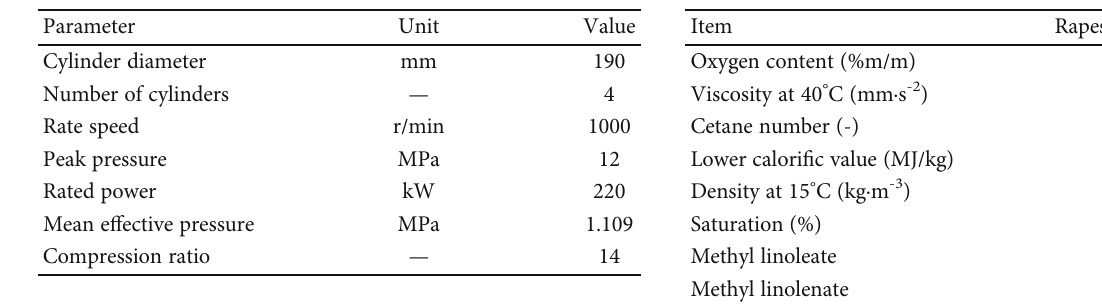
Figure 1: Simulation model of the entire diesel engine. Table 2: Main parameters of diesel engine. Table 3: Physical properties of fuel.